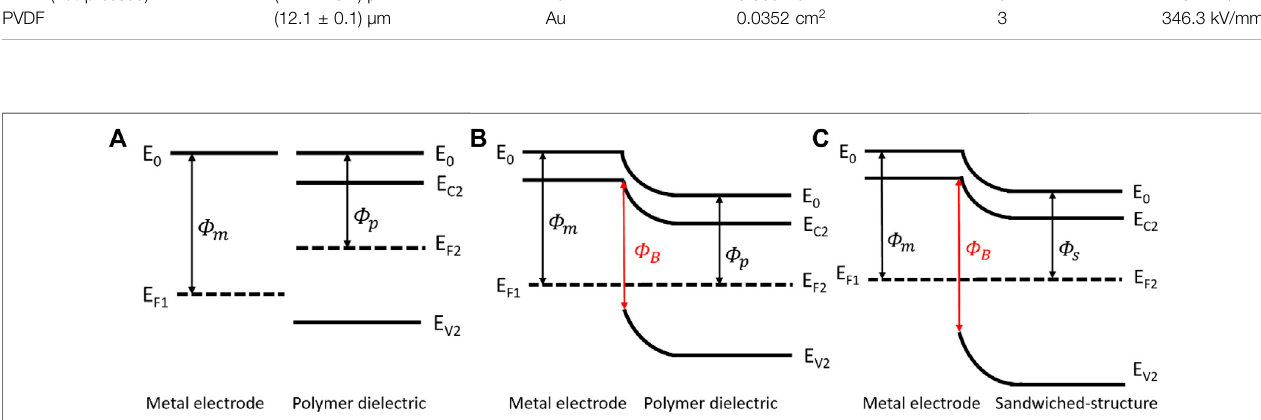
FIGURE4| Energybanddiagramofmetalelectrodeandpolymerdielectricbeforecontact (A) .Energybanddiagramatmetalelectrode/polymerdielectricinterface (B) . Energy band diagram at metal electrode/sandwiched structure interface (C) . Φ m , Φ p , and Φ s is the work function of metal electrode, PVDF, and h-BN/PVDF/h-BN sandwiched-structure, respectively. Φ B is the potential barrier induced by band